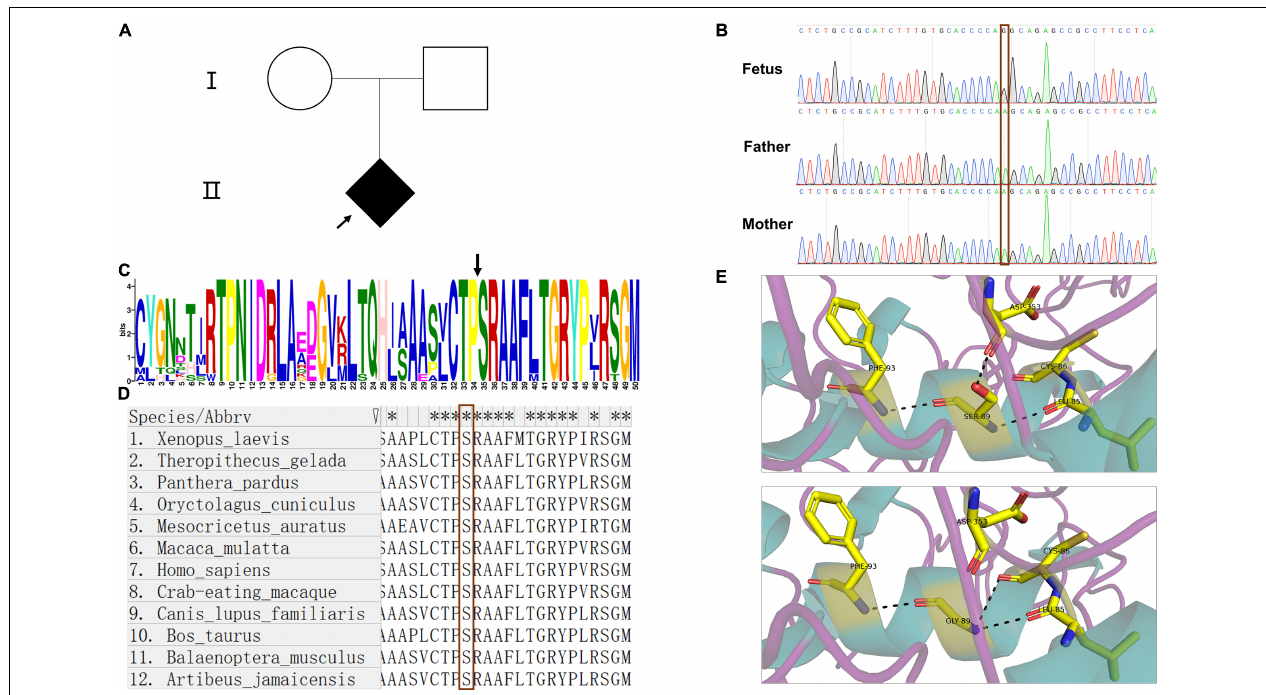
FIGURE 1 | Pedigree of the family, Sanger sequence, and bioinformatics analysis. (A) Pedigree chart of the patient family; the arrow indicates the index fetus. (B) The results of Sanger sequence showed that the mutation in ARSE is a de novo mutation; the red frame indicates the site of the mutation. (C , D) Motif analysis and alignment analysis of the mutation site show the high conservation of the mutated site, the black arrow in (C) and red frame in (D) indicates the mutated site of amino acid. (E) 3D structural model of wild-type and mutated ARSE proteins, which shows the hydrogen bond change in mutated protein. The protein model is stained with secondary structure, and the flexible structures are magenta, the α -helixes are green, and the β -pleated sheets are orange. The protein residues and key interaction residues affected by the mutation are shown in a stick pattern, and the atomic color of the stick residues is as follows: carbon, yellow; nitrogen, blue; and oxygen, red. Hydrogen bonds between proteins are indicated by a black dotted line. The upper is wild-type ARSE. The lower shows the mutation of p.Ser89Gly.